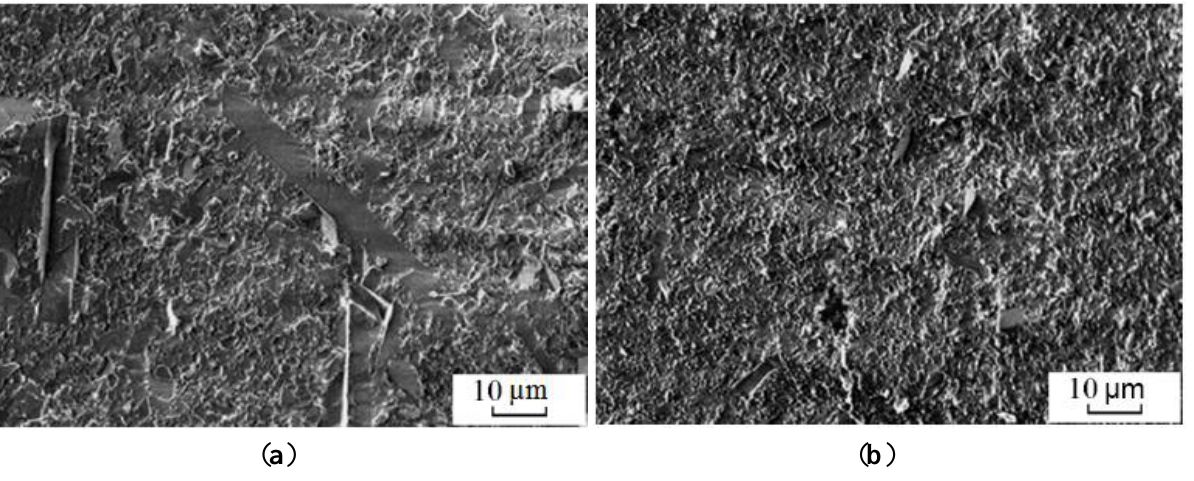
Figure 35. Surface of the alumina-based sintered compacts: ( a ) 1400 °C, 15 min; and ( b ) 1350 °C, 5 min.